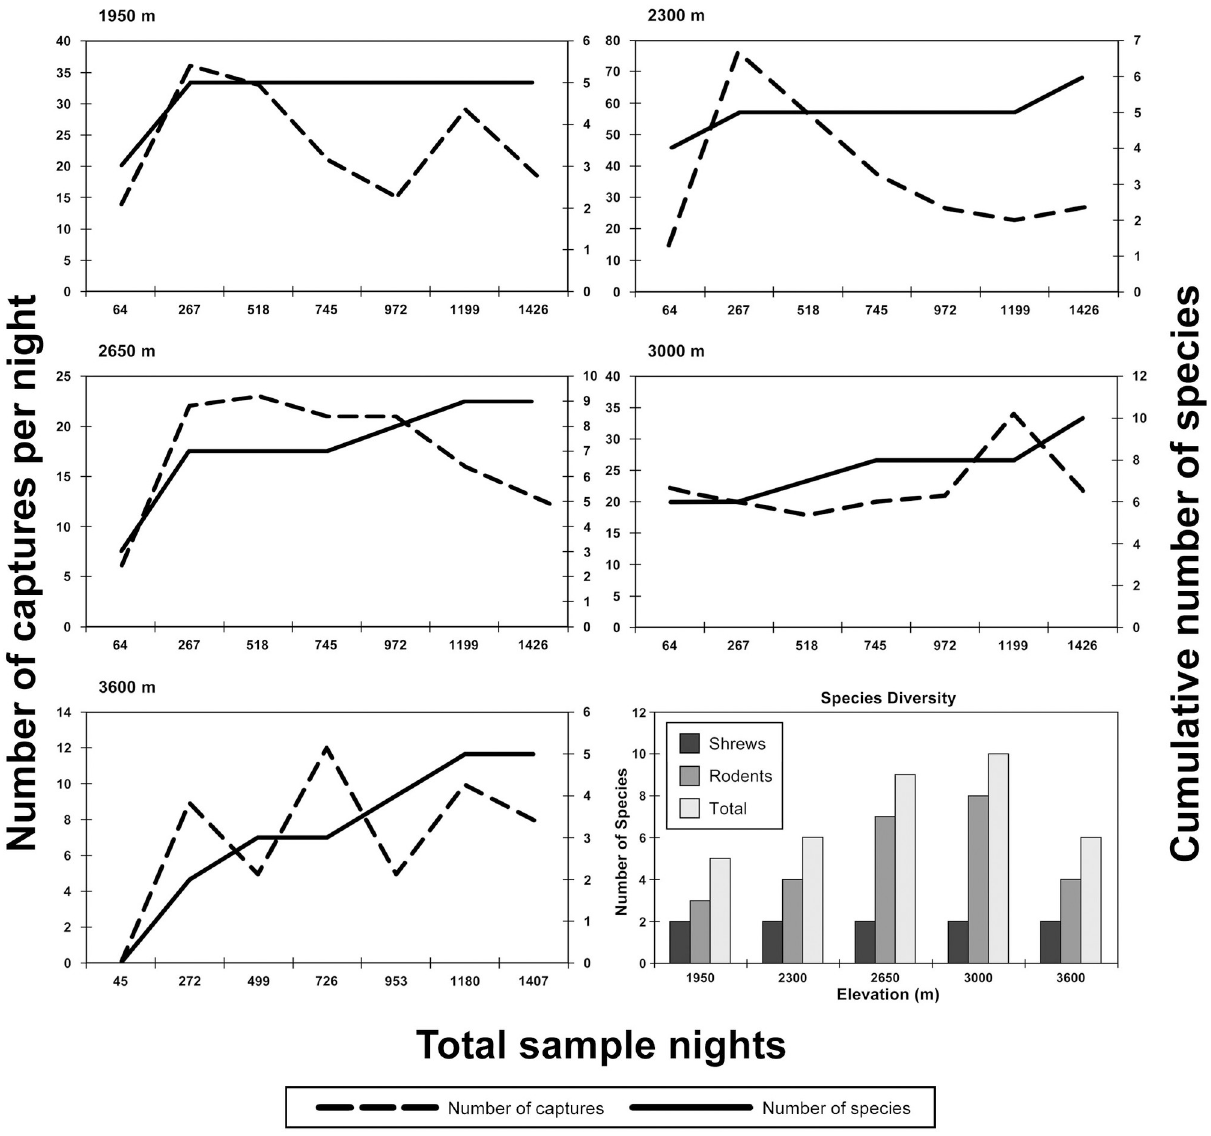
Fig 2. Species accumulation curves (for both pitfall and trap lines combined) for each site surveyed for small mammals on Mt. Meru. The dashed lines represent the number of captures each day; the solid lines represent the cumulative number of new species for the site observed each day. The graph at the lower right shows the number of specimens of shrew, rodent, and combined small mammals captured at each